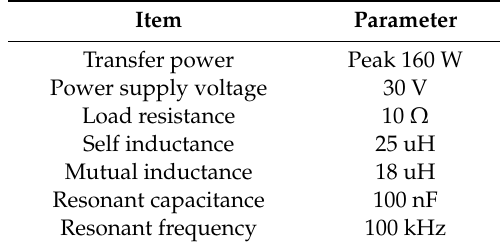
Table 1. Parameters of MRC-WPT.